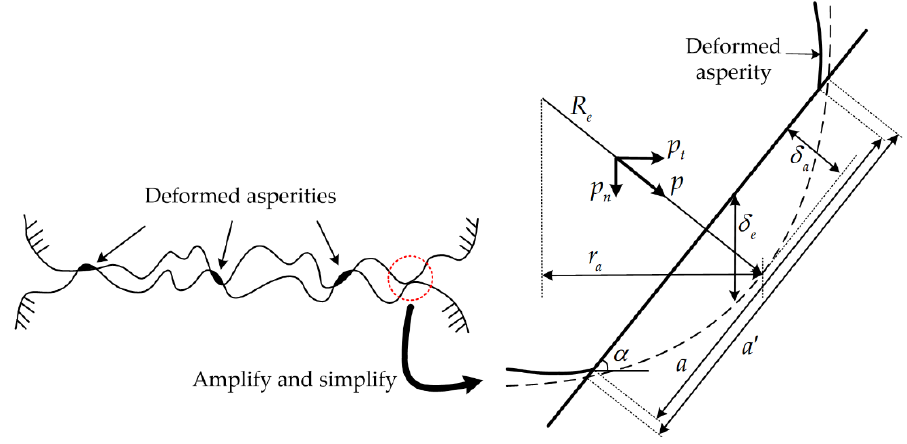
Figure 2. Schematic of oblique asperity contact.